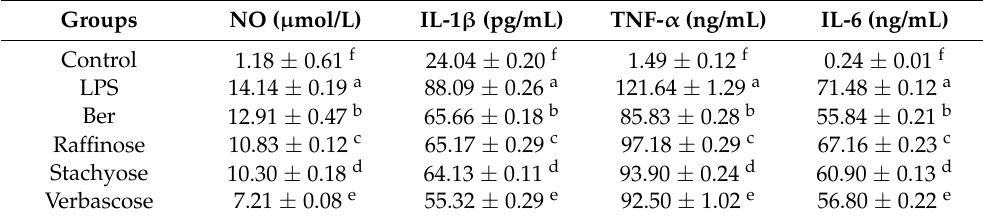
Table 2. NO, IL-1 β , TNF- α , and IL-6 levels analysis of culture media obtained from cells treated with LPS and natural